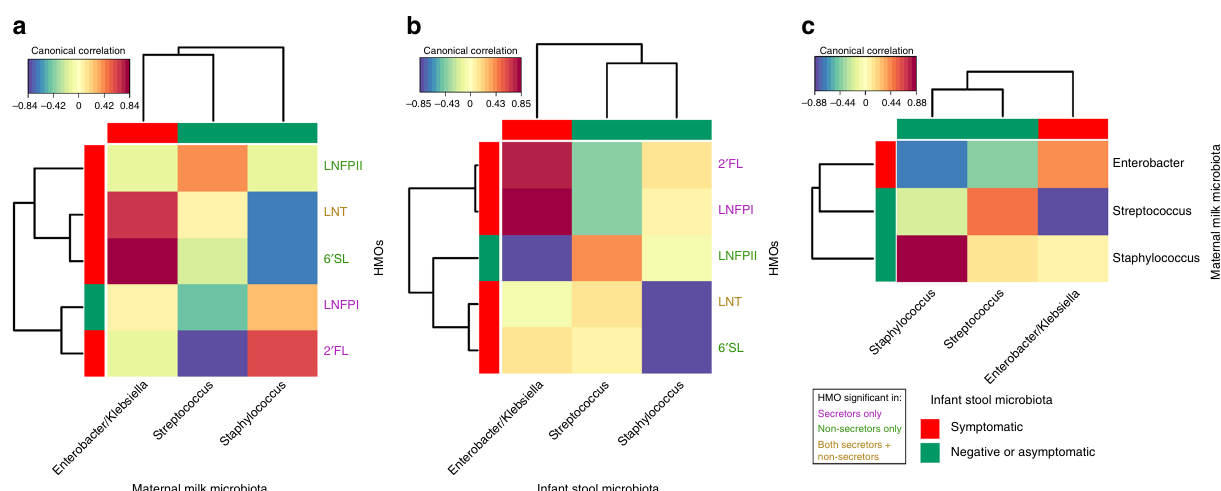
Fig. 5 Correlations between HMOs and microbiome in fl uence symptomatic infections. Canonical correlations between HMOs and maternal breast milk microbiome ( a ), between HMOs and infant stool microbiome ( b ), and between HMOs, maternal breast milk microbiome, and infant stool microbiome ( c ). The HMO data are based on nmol/ml concentrations in breast milk while microbiome data is based on genus relative abundance. Bars surrounding the plots at the base of the dendrogram are colored according to signi fi cant associations with symptomatic (red) or negative/asymptomatic (green) infants. HMO name color indicates if the HMO was signi fi cantly associated with secretors only (purple), non-secretors (green), or both (yellow)